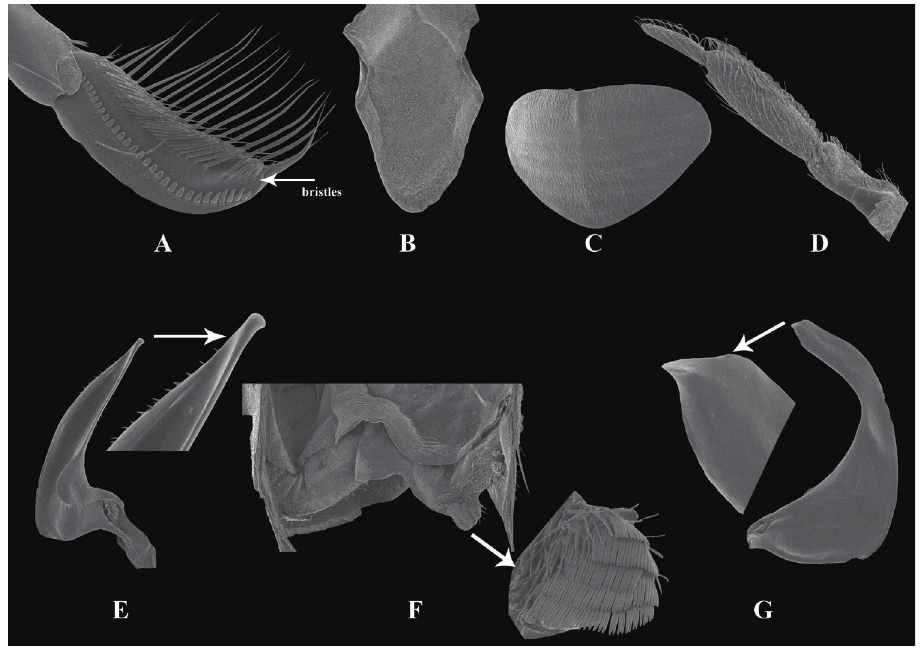
Figure 2. Male of Cenocorixa yuanjiangensis sp. nov. A tibia B metaxyphus C pronotal carina D antenna E left paramere F seventh abdominal segment (strigil) G right paramere.